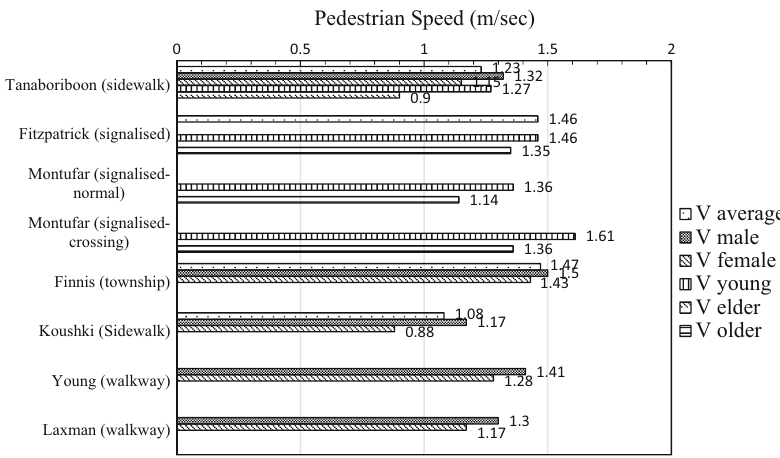
Fig. 7 Pedestrian walking speeds from various